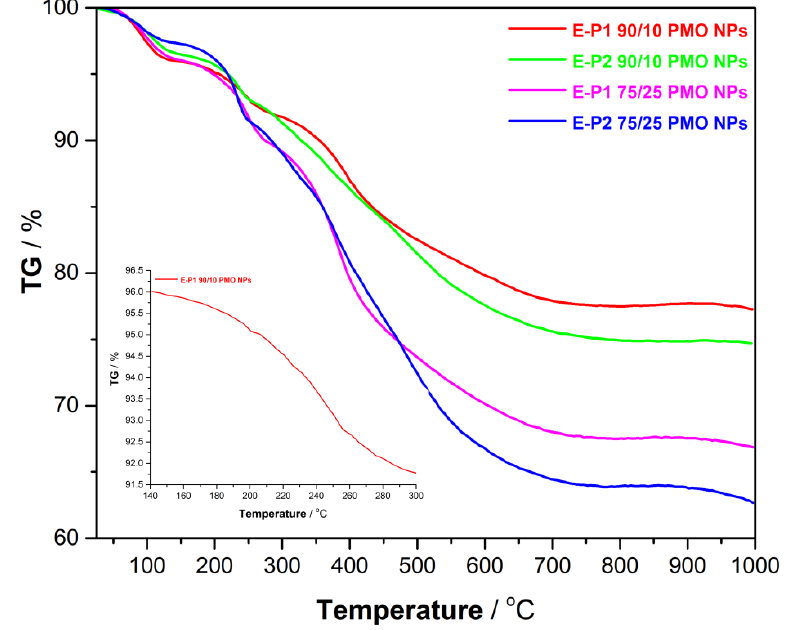
Figure 4. TGA of E-Pn PMO NPs .